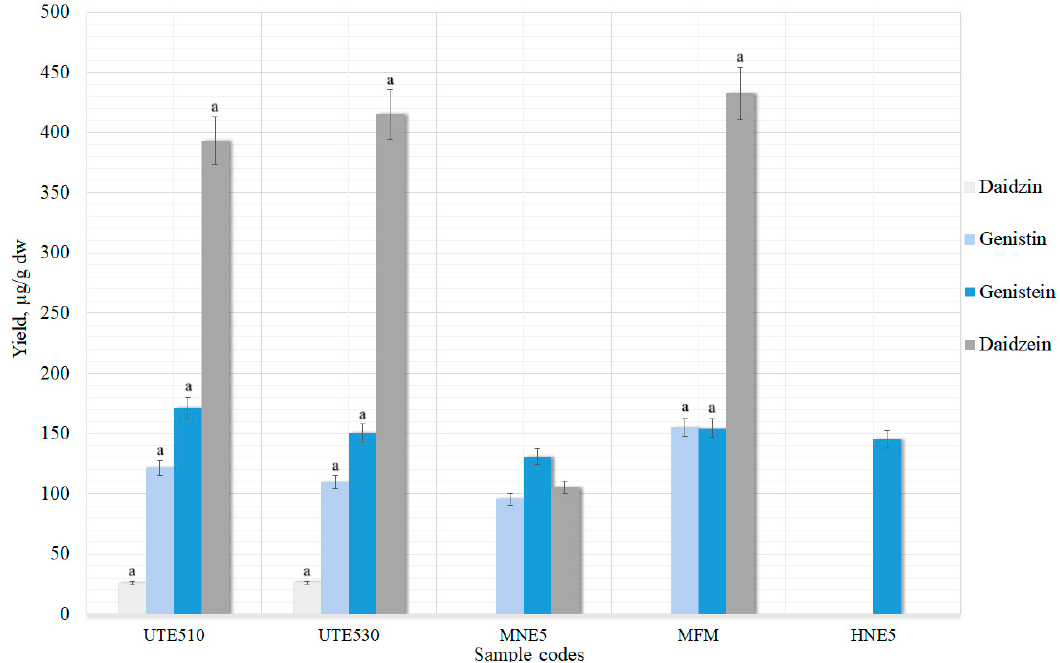
Figure 7. UAE treatment with thermal hydrolysis, HRE, ME and ME with natural hydrolysis on the maximal extraction yield of genistein and daidzein in extracts. a p < 0.05 vs. maceration with 50% ethanol (MNE5). Sample codes and preparation conditions are displayed in Table 1.